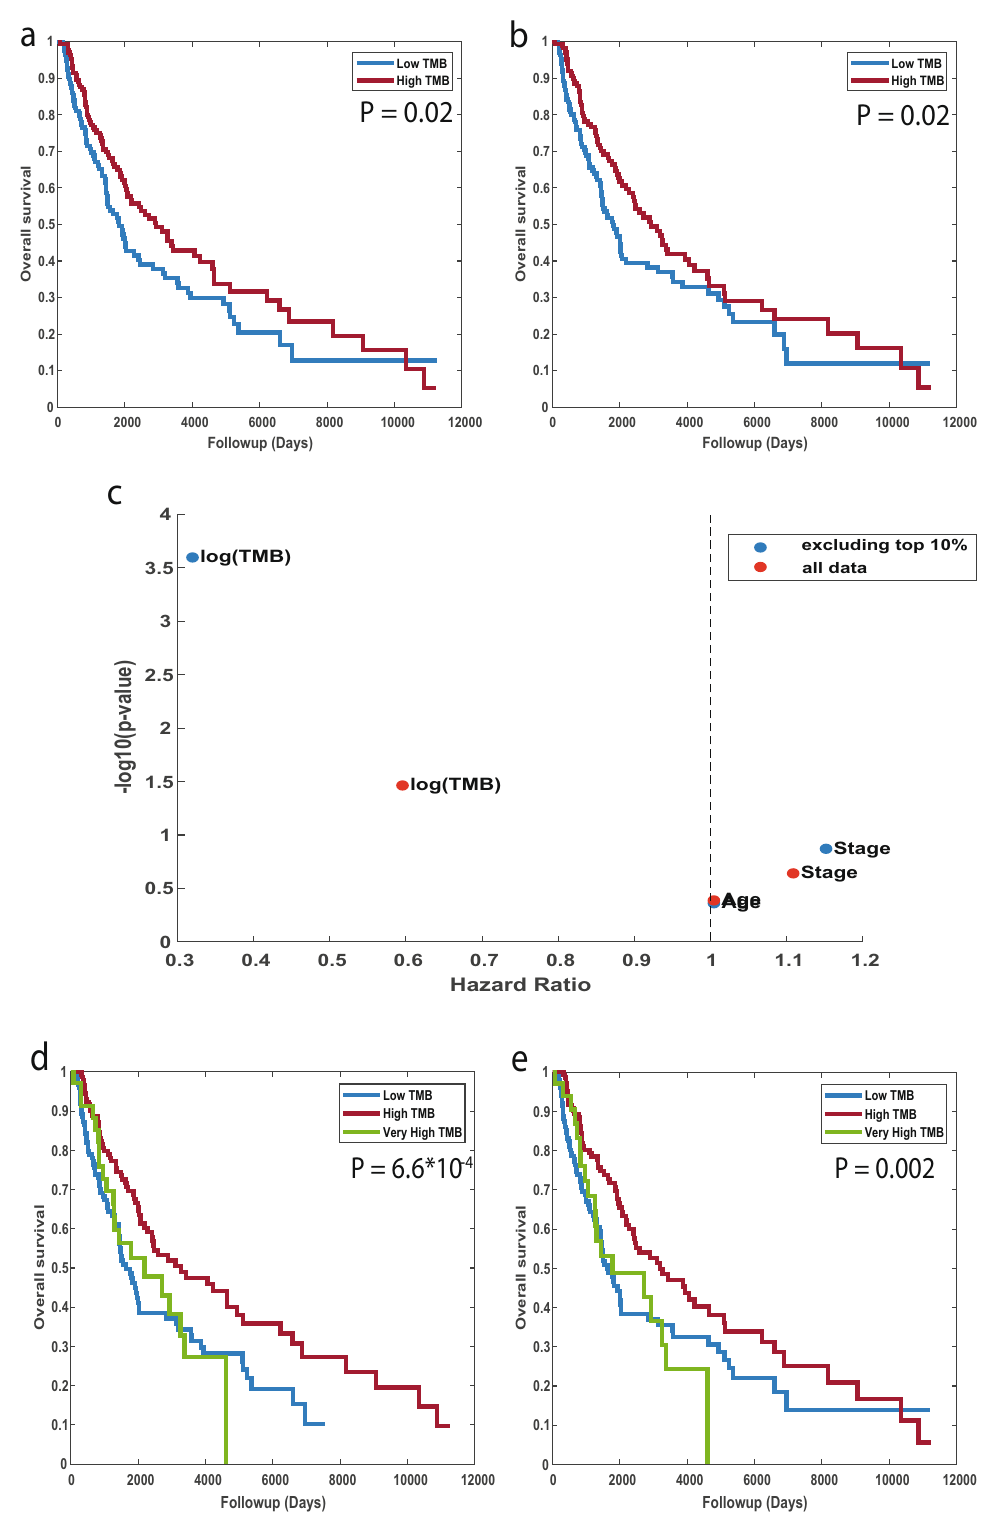
Fig. 3 Association between Tumor Mutational Burden (TMB) and patient survival. Kaplan – Meier survival curves for patients with high vs. low TMB estimated on the basis of predicted somatic mutations from RNA alone ( a ); or on the basis of DNA with a matched-normal sample ( b ). The median TMB value is used to de fi ne the ‘ low TMB ’ and ‘ high TMB ’ subgroups. P-values are computed using a log-rank test. c Hazard Ratio vs. – log 10 ( p -value), obtained by a multivariate Cox proportional hazards regression analysis. Red dots represent the values obtained when all samples are used and blue dots represent the values obtained after excluding the top 10% of samples (very high TMB). d , e Kaplan – Meier survival curves as in a and b , respectively, with patients divided into three groups with very-high vs. high vs. low TMB. p -values are computed using logrank test. Subgroups were split by using the top 10 th percentile for the very high group, and median for the remaining samples. Source data are provided as a Source Data fi